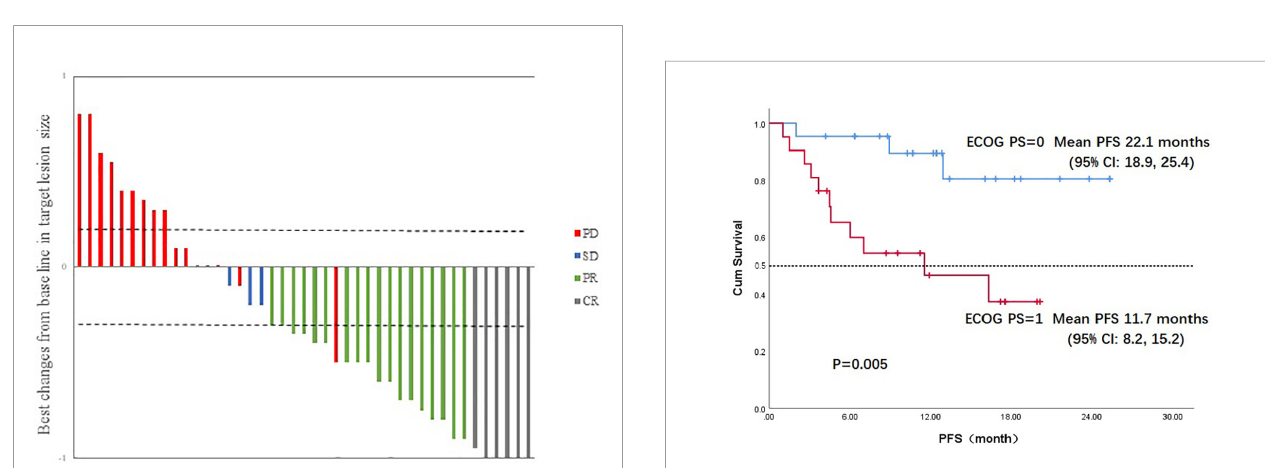
FIGURE 3 | Kaplan-Meier survival curve of overall survival in 43 head and neck cancer patients. OS,overall survival;CI, con fi dence interval.